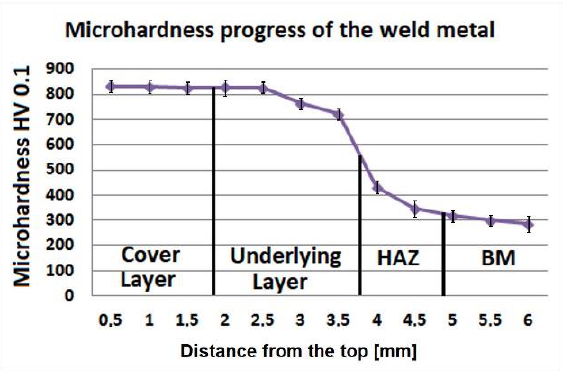
Figure 21. The course of microhardness of the sample with welding.